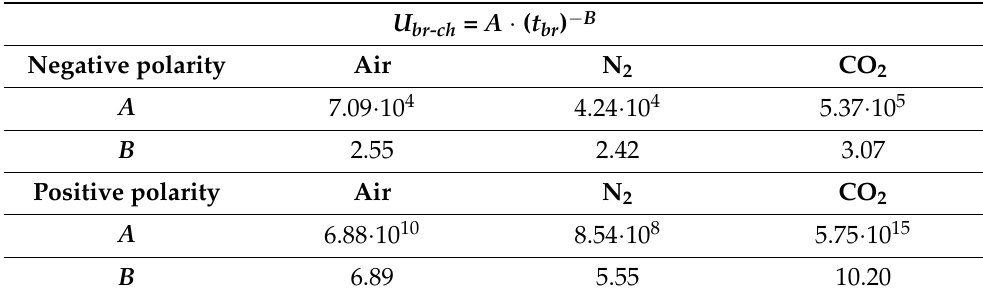
Table 1. Parameters A and B for fitting function (3) for air, N 2 and CO 2 for negative and positive